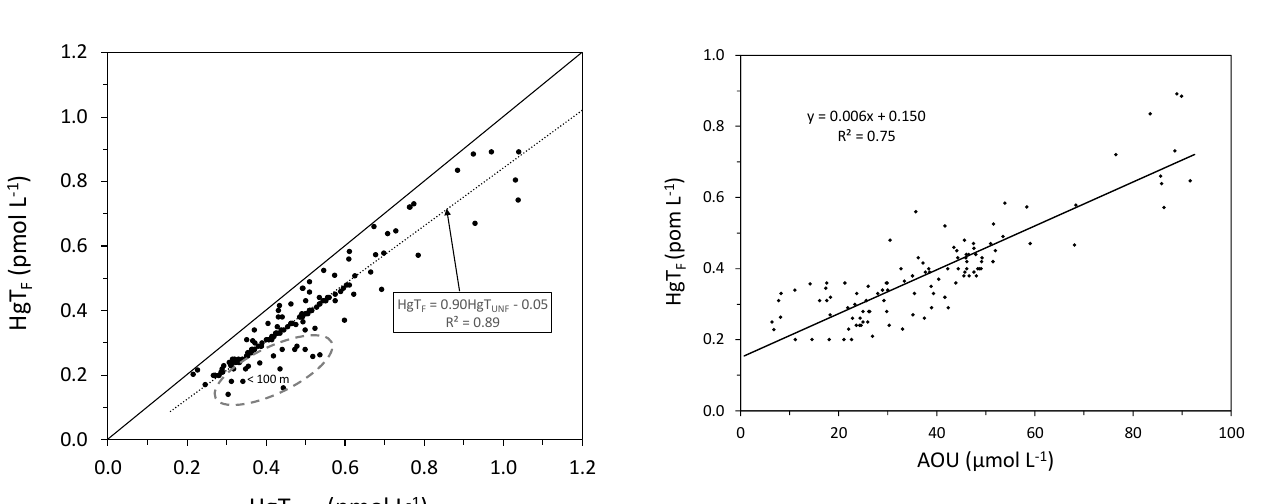
Figure 4. Total Hg in filtered samples (HgT F ) vs. apparent oxygen utilization (AOU) along the G EOTRACES -GA01 transect. along the G EOTRACES -GA01 transect is represented in Fig. 2. The main features of HgT UNF concentrations are an eastward increase from Greenland to Europe and a down- ward increase from subsurface to bottom waters. In addi- tion, the lowest and highest (most variable) HgT UNF